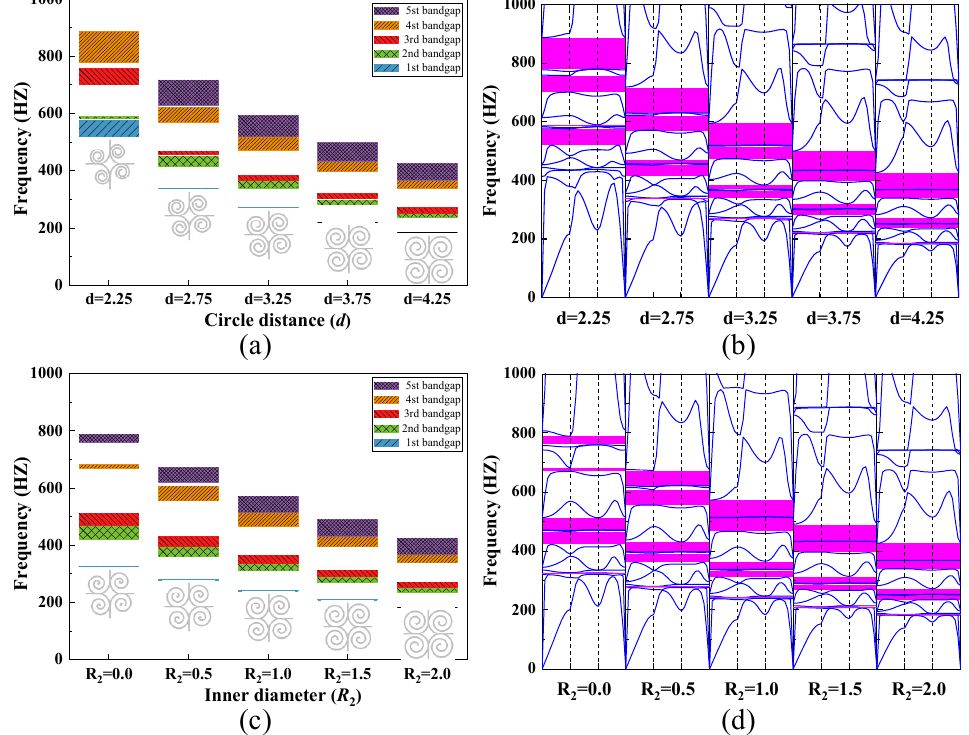
Figure 13. The dependence of the bandgap width on ( a , b ) the circle distance d , and ( c , d ) the inner diameter R 2 .